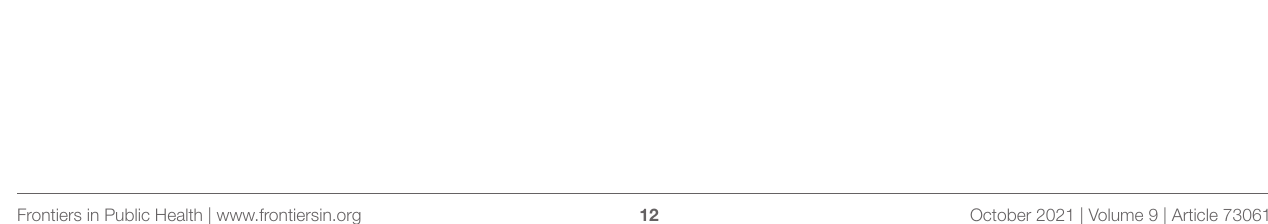
Frontiers in Public Health |